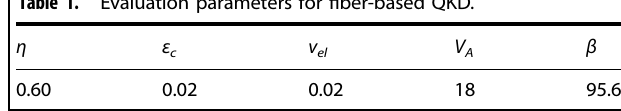
Table 1. Evaluation parameters for fi ber-based